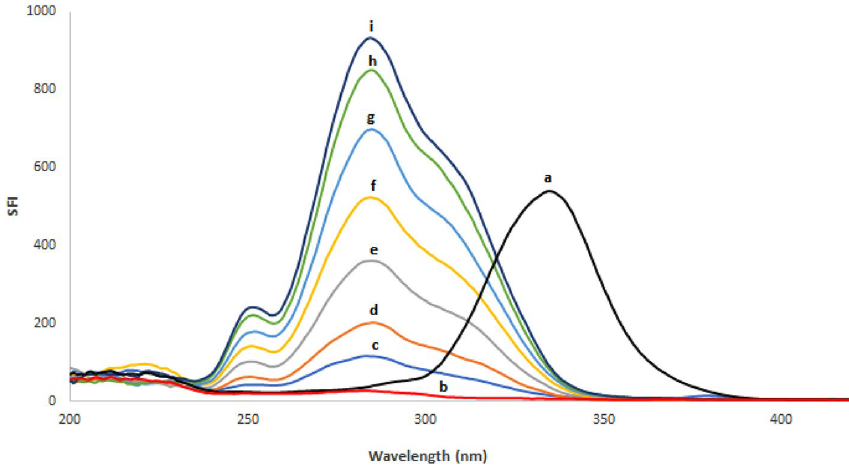
Figure 4. Synchronous fluorescence spectra of (a) SIM (0.60 μg/mL), (b) Blank and (c-i: 0.10, 0.20, 0.40, 0.60, 0.80, 1.00, 1.10 μg/mL) of REM at Δλ = 90 nm.